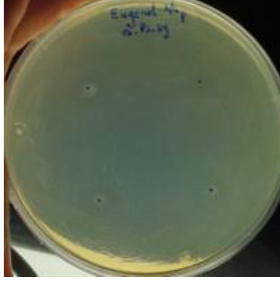
Figure 5 . Pseudomonas syringae cultures grown in the presence of eugenol (after 3 days), in differ- ent concentrations. ( a ) C 1 = 25%; ( b ) C 2 = 50%; ( c ) C 3 = 100%.